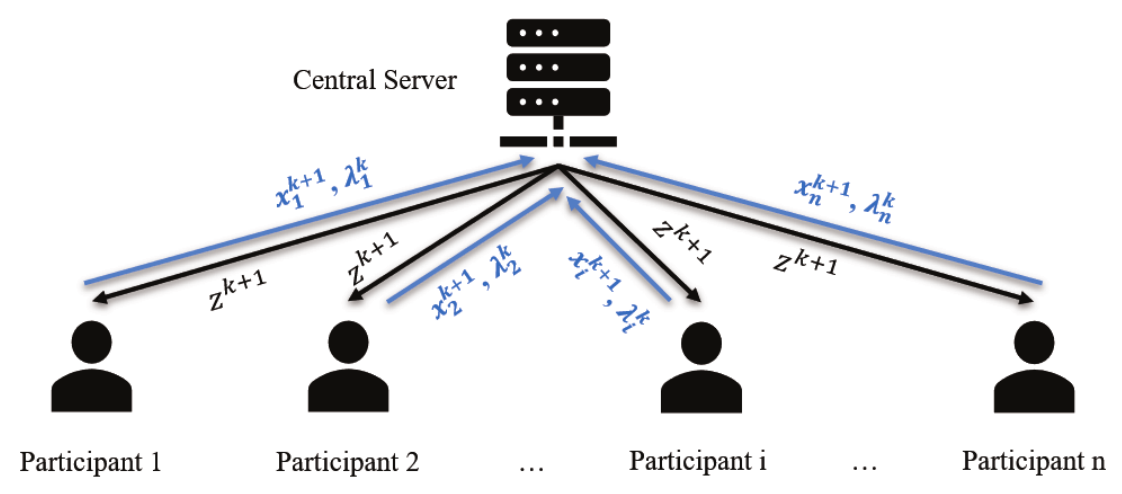
Figure 1. ADMM based collaborative machine learning